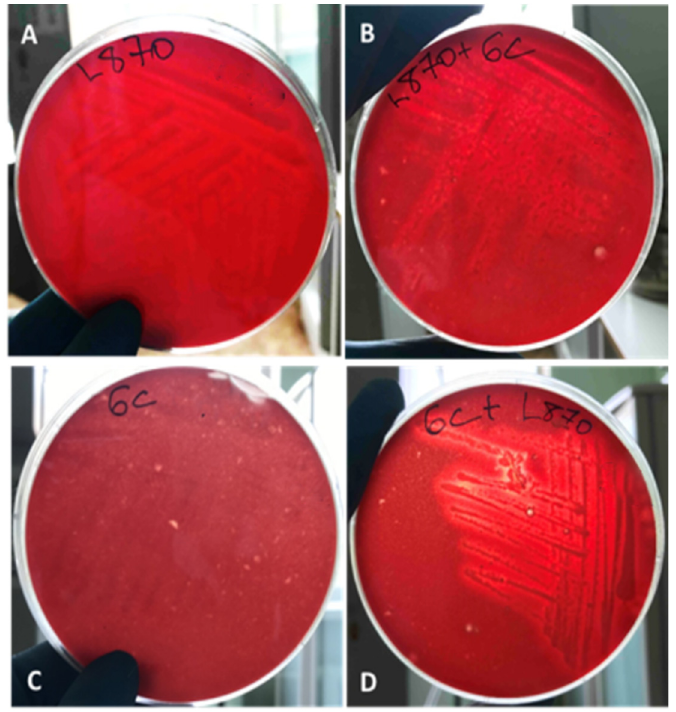
Figure 3. Growth on blood agar 48–72-h biofilms of Bacillus sp. after co-cultivation with L. monocytogenes : ( A )—the absence of a transparent zone of hemolysis around the colonies of L. monocytogenes (monobiofilm); ( B )—partial lysis around the colonies of L. monocytogenes , sown after co-cultivation with Bacillus sp.; ( C )—absence of a transparent zone of hemolysis around the colonies of the Bacillus sp. strain (monobiofilm); ( D )—the appearance of a transparent zone of hemolysis around the colonies of the saprotroph Bacillus sp. after co-cultivation in biofilm with L. monocytogenes